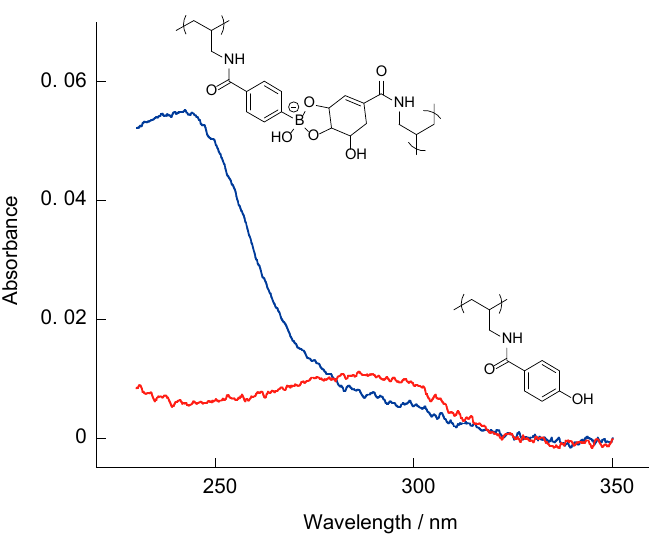
Figure 8. UV-vis absorption spectra of a (SA-PAH/PBA-PAH) 10 film before (Blue line) and after 60 min